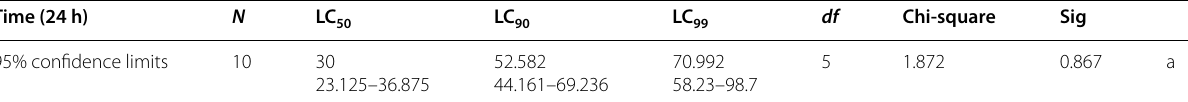
Table 1 LC , LC and LC values of E. elaterium fruit juice against larvae of G. mellonella 50 90 99